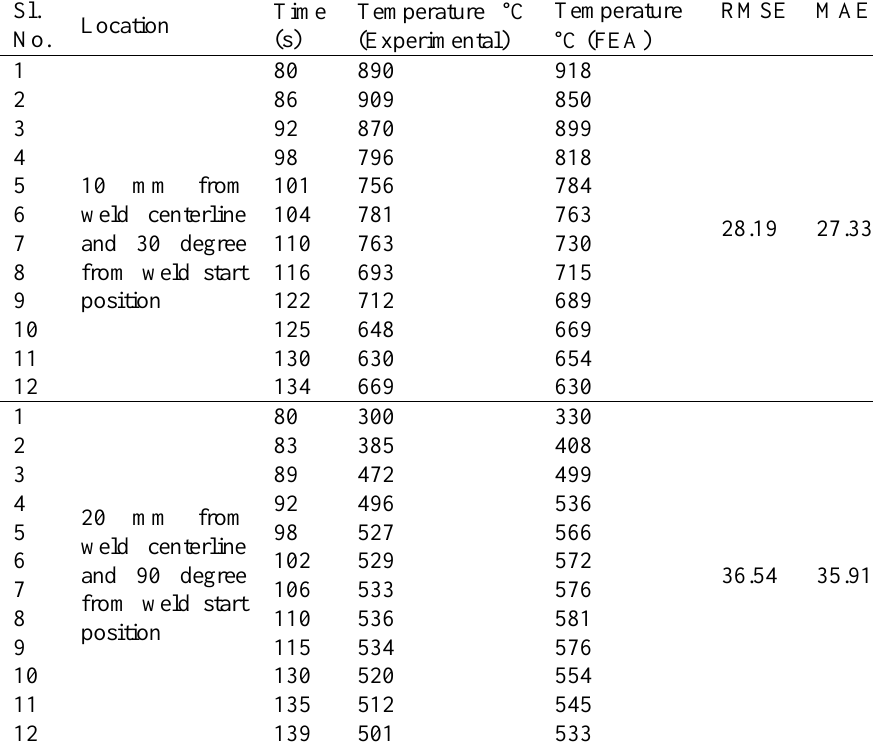
Table 3. Comparison of temperature recorded from the experimental setup and FE